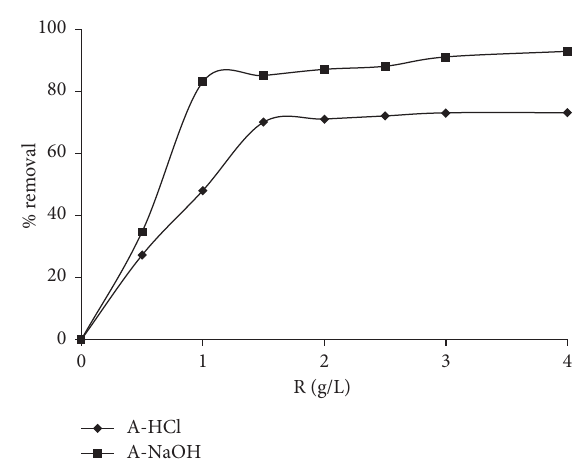
Figure 9: Effect of adsorbent dosage on the discoloration rate of the industrial effluent A-NaOH and